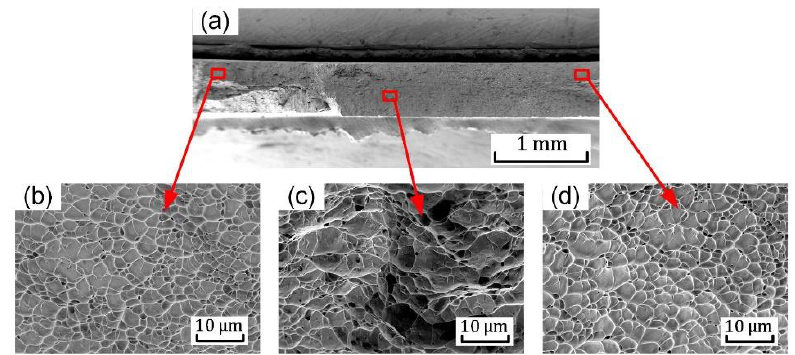
Figure 15. SEM images of fracture surface for the notched (R = 0.1 mm) tension sample: ( a ) overall view; ( b – d ) images of the regions shown in ( a ).